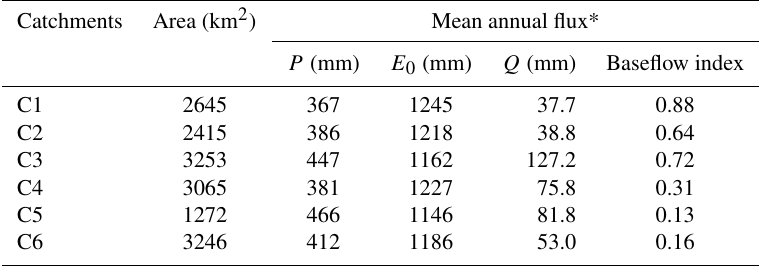
Table 1. The characteristics of the study catchments shown in Fig. 1.